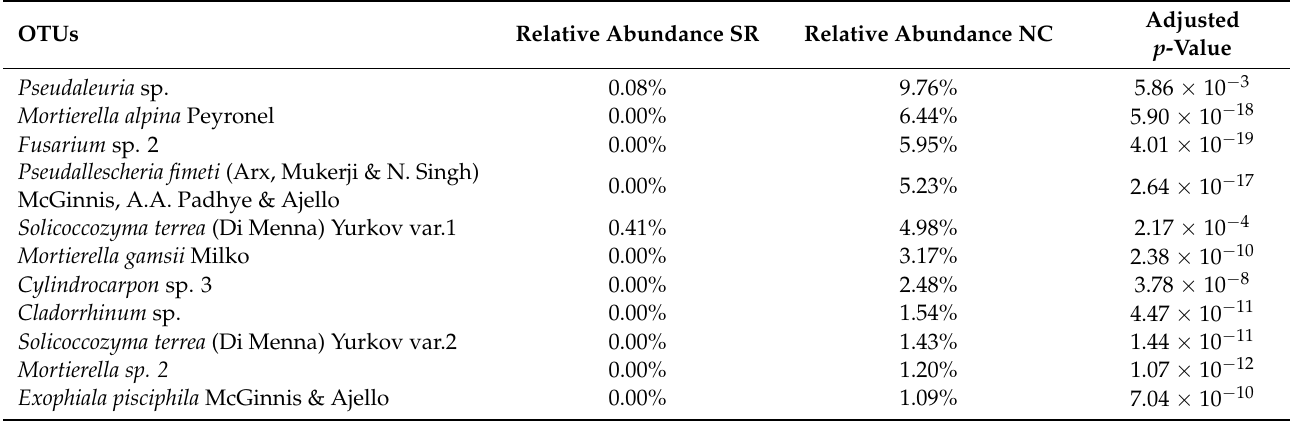
Table 5. List of OTUs with a significantly higher abundance in NC plots compared with SR plots (differential expression analysis based on the negative binomial distribution). The p-values shown are adjusted by false discovery rate (FDR, cut-off at